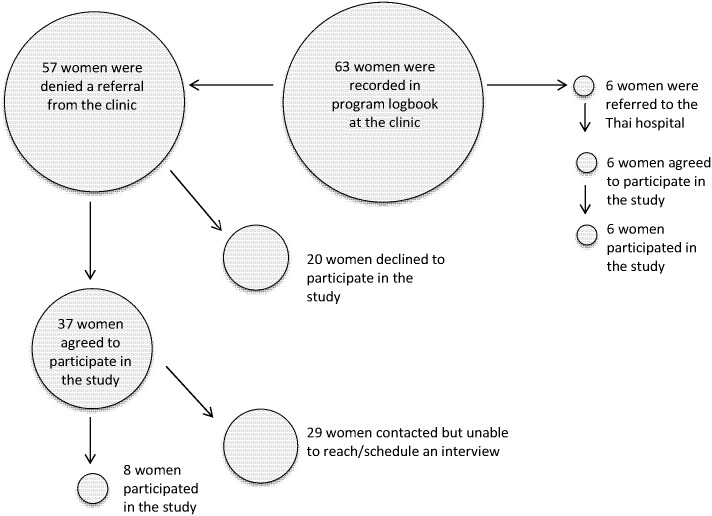
Participant sample.